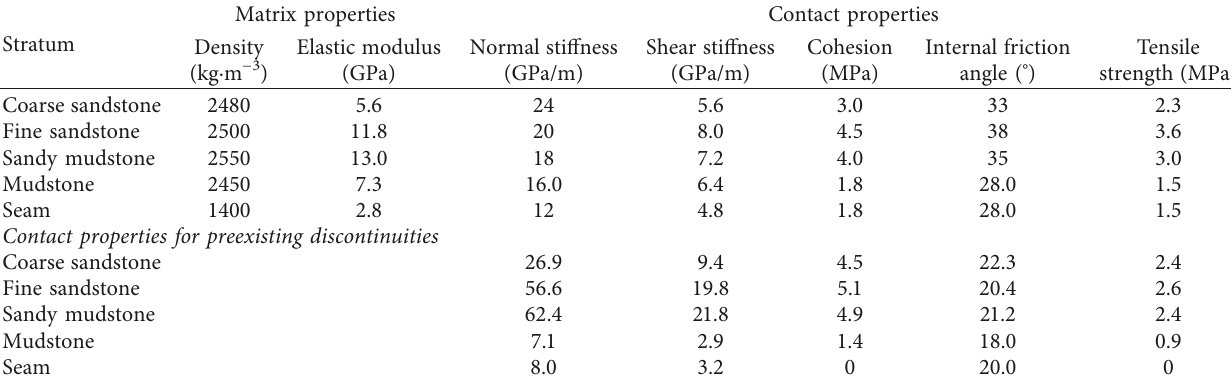
Table 1: Simulation parameters for the rock mass and